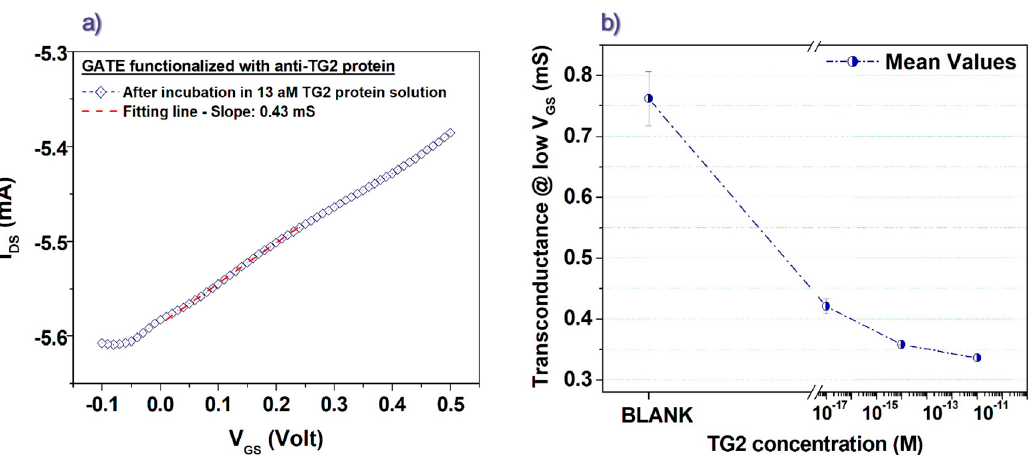
Figure 3. ( a ) OECT transfer curves recorded (at V DS = − 0.1 V) for gate electrodes functionalized with anti TG2 antibodies before (Blank) and after incubation in solutions with different concentrations of rhTG2 protein. ( b ) Transconductance values extracted from the transfer curves in the panel ( a ).